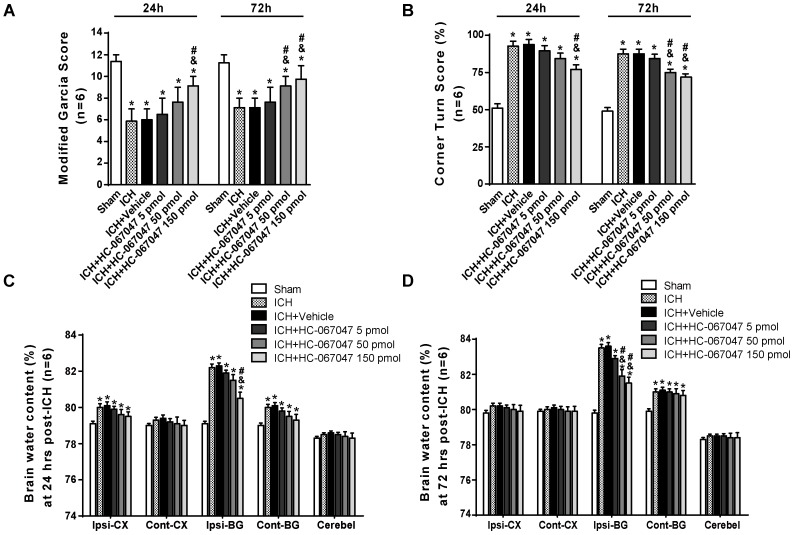
The effects of HC-067047 administration on neurological deficits and brain edema after ICH. (A) The results from the modified Garcia test and (B) corner turn test obtained from the sham, ICH, vehicle, and HC-067047 treatment groups (5, 50, or 150 pmol per rat) 24 and 72 h after the operation are shown. (C) Brain water content assessments at 24 h after the operation in sham, ICH, vehicle, and HC-067047 treatment groups (5, 50, or 150 pmol per rat) are shown. (D) Brain water content assessments at 72 h after the operation in sham, ICH, vehicle, and HC-067047 treatment groups (5, 50, or 150 pmol per rat) are shown. Brain specimens were divided into the following four parts: ipsilateral basal ganglia (Ipsi-BG), ipsilateral cortex (Ipsi-CX), contralateral basal ganglia (Cont-BG), and contralateral cortex (Cont-CX). The cerebellum (Cerebel) was used as the internal control, n = 6 rats per group. Data are presented as the medians ± 25th–75th percentiles (A) or the means ± standard errors of the means (B–D). ∗p < 0.05 compared with the sham group; &p < 0.05 compared with the ICH group; #p < 0.05 compared with the vehicle group.